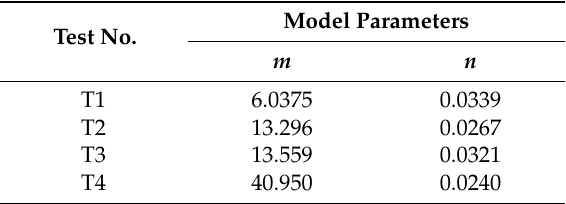
m and n : best-fit parameters.